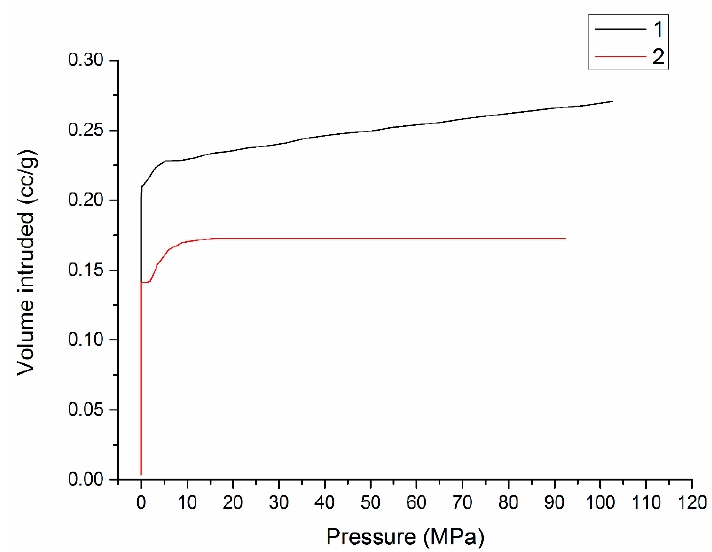
Figure 1. Cumulative volume of intruded mercury into coal from low to high pressure.